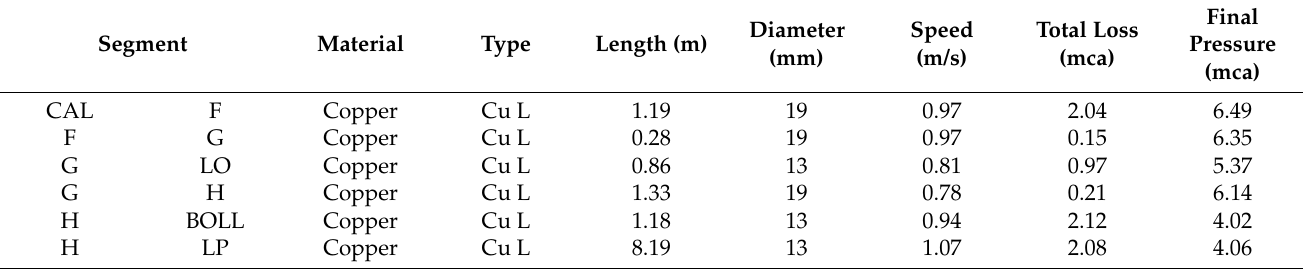
Table 17. Loss summary table for hot potable water system, retail store type 1.